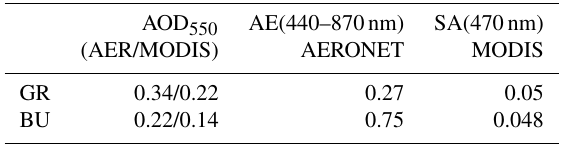
Figure 5. AOD-constrained aerosol extinction profiles retrieved with the ground-based EARLINET lidars (solid line) and CALIPSO (dashed line) for the Granada (green) and Bucharest (blue) stations. Table 1. AERONET and MODIS retrieved AOD at 550nm; the Angstrom exponent between 440 and 870nm, AE(440–870nm), re- trieved by AERONET; and surface albedo (SA) at 470nm obtained from MODIS data above the Granada and Bucharest stations.